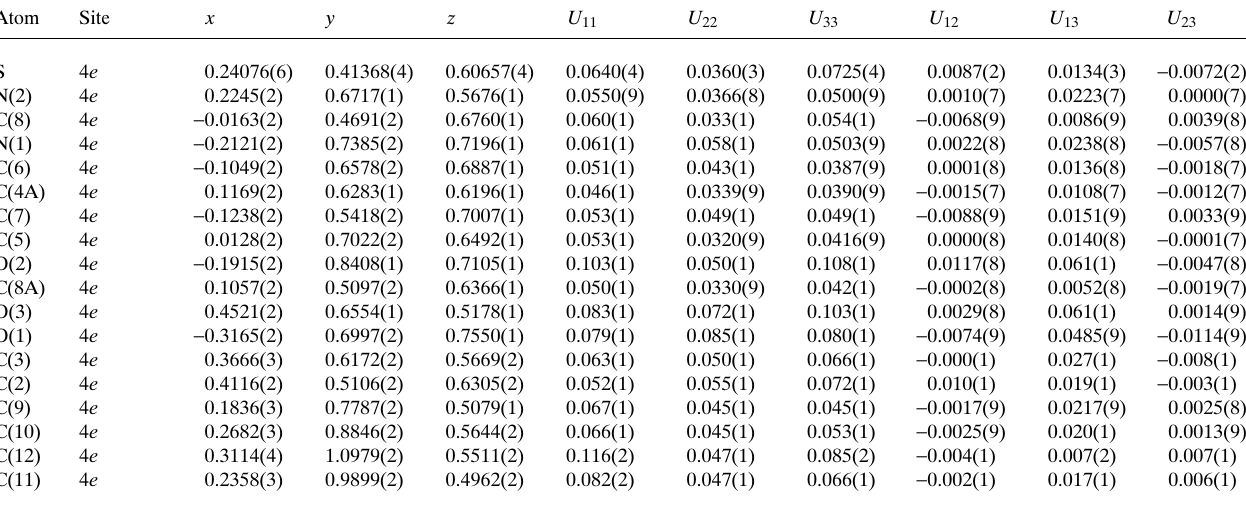
Table 3. Atomic coordinates and displacement parameters (in Å 2 )